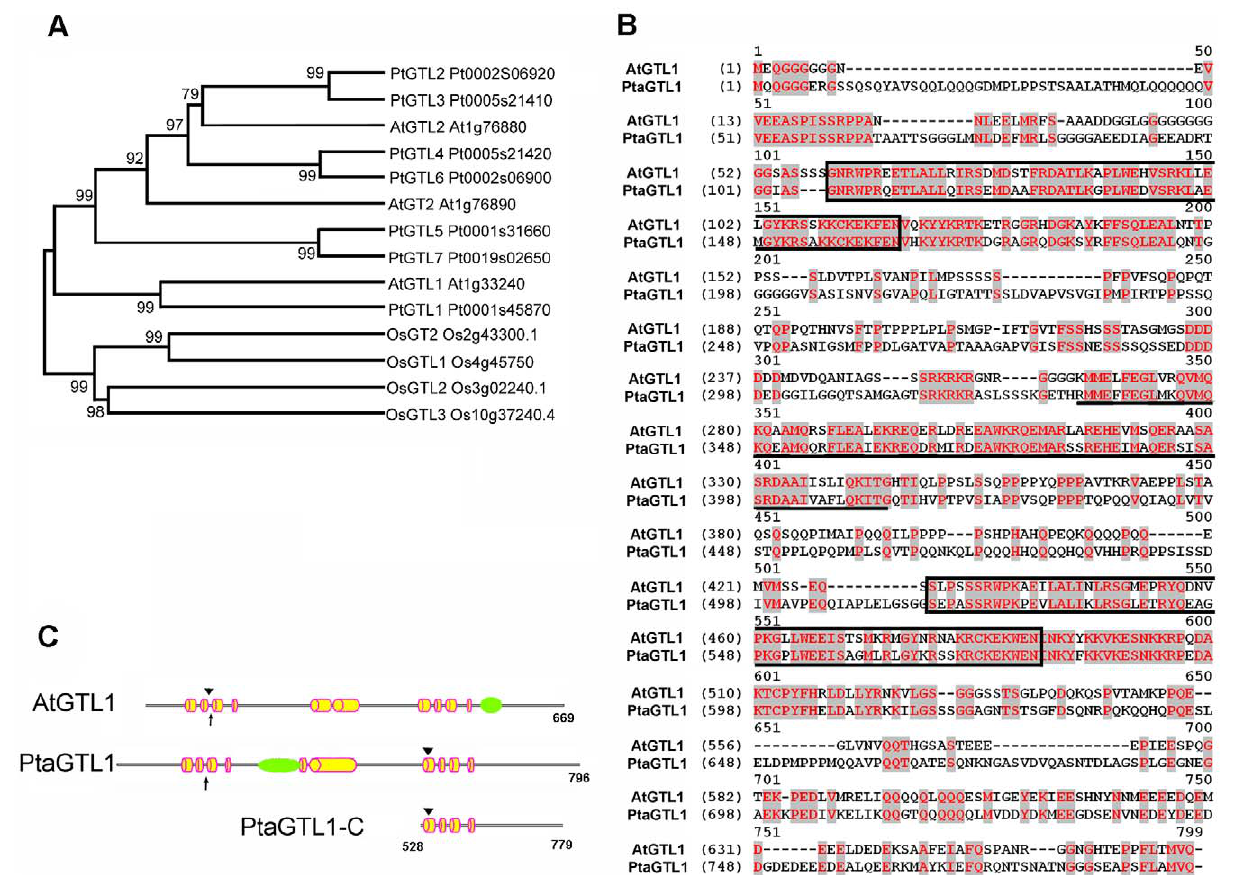
Figure 1. Insilico sequence analyses identify PtaGTL1 as an AtGTL1 ortholog. A. Phylogenetic analysis of GT-2 transcription factors of Arabidopsis thaliana , Oryza sativa , and Populus trichocarpa was performed by the neighbor joining method using MEGA 5.0 with 1000 boot strap replicates [43]. B. Protein sequences of AtGTL1 and PtaGTL1 were aligned with the CLUSTW program. Fragments corresponding to the N- and C- terminal DNA binding domains are enclosed in boxes and the conserved central helical region is underlined. C. Schematic diagrams of AtGTL1 and PtaGTL1. Yellow cylinders represent predicted helices (http://www.compbio.dundee.ac.uk/www-jpred/index.html); arrowheads identify the position of predicted CaM-binding sites (http://calcium.uhnres.utoronto.ca/ctdb/ctdb/home.html); arrows identify the position of nuclear localization sequences (http://cubic.bioc.columbia.edu/cgi/var/nair/resonline.pl); green ellipses identify the position of PEST sequences (http://emboss. bioinformatics.nl/cgi-bin/emboss/epestfind). The PtaGTL1-C fragment (from amino acid residue 528 to 779 of PtaGTL1) that was used for promoter and CaM binding assays is also illustrated.